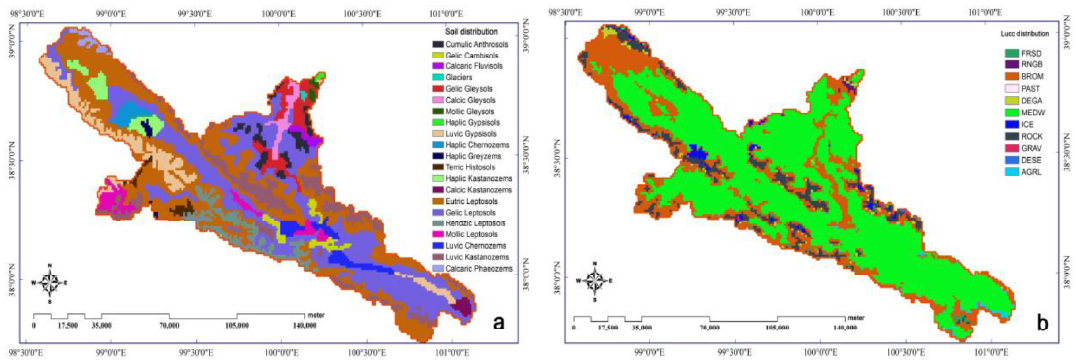
Figure 2. Soil ( a ) and Lucc ( b ) distribution of Heihe River basin (HRB).